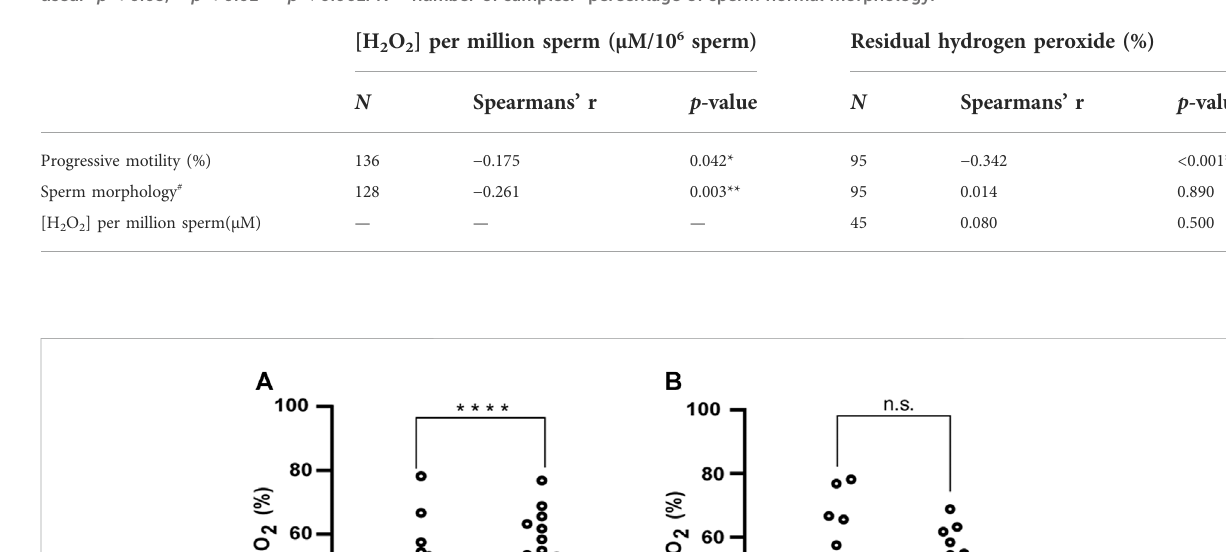
TABLE4Correlationbetweensemenparametersand[H 2 O 2 ]orpercentageofresidualhydrogenperoxide(antioxidantcapacity).Spearman ’ stestwas used. * p < 0.05, ** p < 0.01 *** p < 0.001. N = number of samples. # percentage of sperm normal